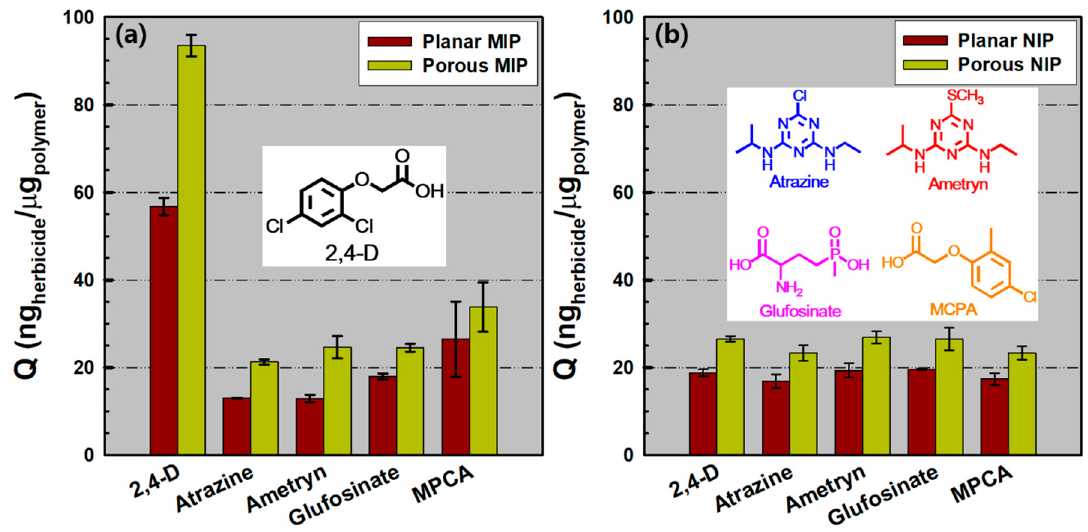
Figure 5. Q values as a function of time on ( a ) the pl - and p -MIP films and ( b ) pl - and p -NIP films in each analogous herbicide solution (2,4-D, atrazine, ametryn, glufosinate, or MCPA) with a fixed concentration (10 − 1 mM) for the 1 h rebinding process ( n = 3).